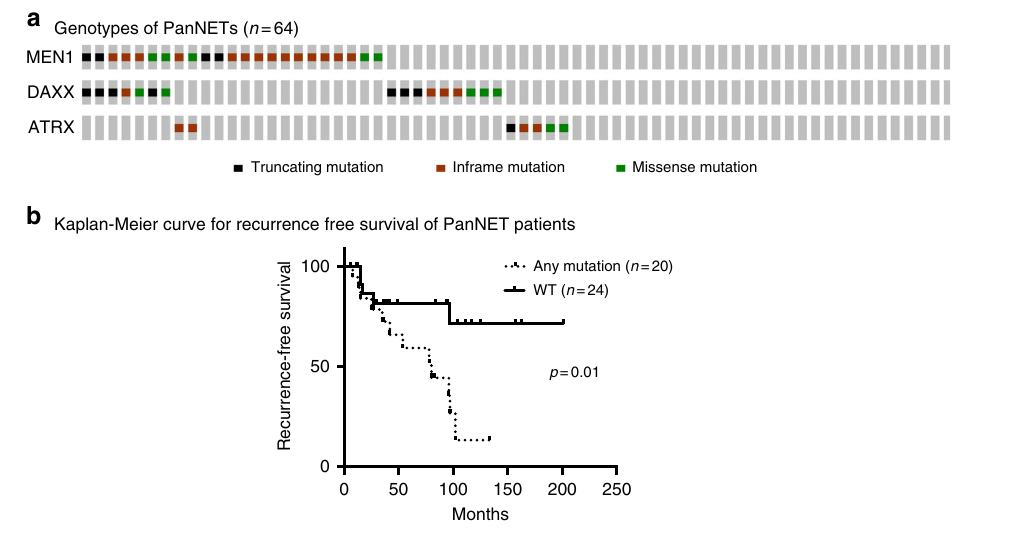
Fig. 1 Mutational landscape of ATRX , DAXX , and MEN1 in PanNETs. a Oncoprint mutational pro fi le for PanNETs samples. ATRX/DAXX/MEN1 mutations were identi fi ed in 37/64 (58 %) of PanNETs using Sanger sequencing. b Among 44 patients who initially presented with localized PanNETs (without distant metastasis), those with A-D-M mutant genotype had a worse recurrence free survival outcome than those A-D-M WT genotype in their primary tumors. A-D-M mutated samples are annotated as any mutation ( n = 20) and A-D-M WT samples annotated as WT ( n = PanNETs as compared to A-D-M WT PanNETs (Fig. 2c). Among A-D-M mutant PanNETs, mutants with the same genotype (mutations in ATRX / DAXX / MEN1 ) did not show greater gene expression correlation. These data suggest that A-D-M mutant PanNETs are a more homogeneous group compared to A-D-M WT PanNETs.